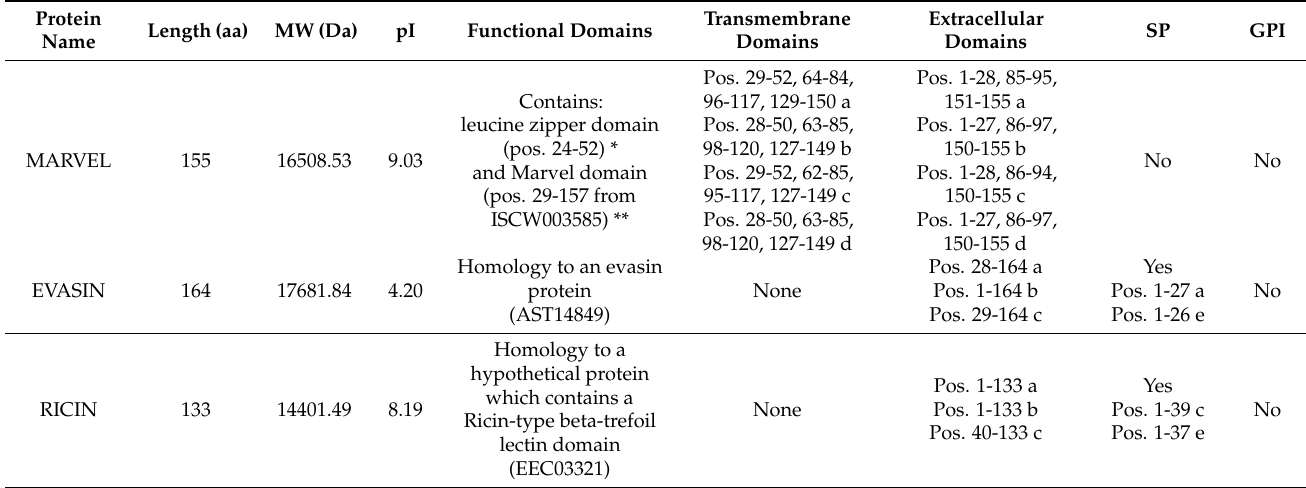
Table 2. Topology and structure properties of the selected targets. Several bioinformatic tools were used to obtain this data. (Prosite (*), VectorBase (**), Phobius (a), TMHMM (b), CCTOP (c), SACS TMHMM (d), and SignalP